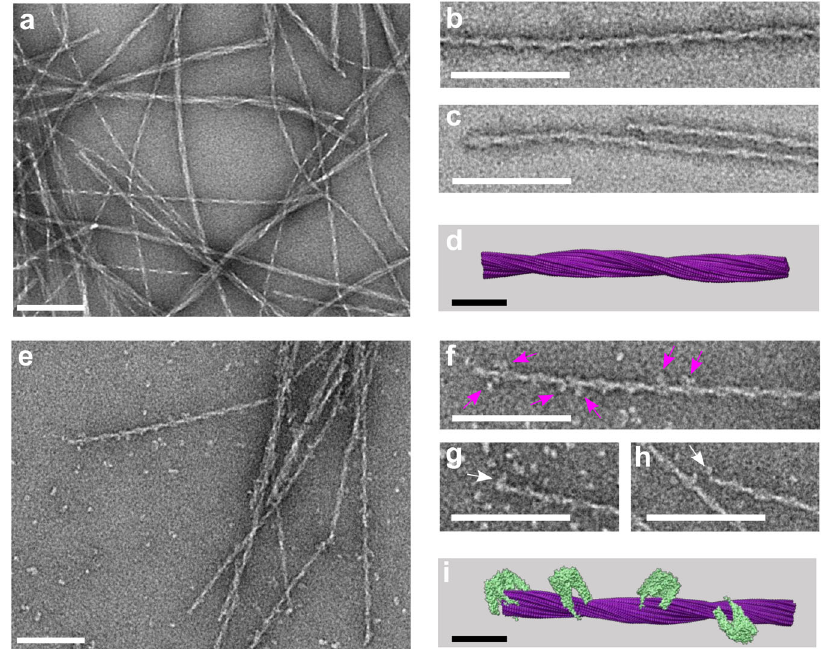
Fig. 4 EM images of PhPFD bound to IAPP fi brils. a Electron microscopy images of IAPP fi brils, stained with sodium silicotungstate (SST) at 30,000x magni fi cation. b , c Close-ups of main fi bril species. d Molecular model of polymorph 1 of the IAPP fi bril (PDB: 6Y1A) 13 . e Preformed IAPP fi brils (67 µ M, monomer equivalent concentration) were incubated with PhPFD in a ratio of 100:1 for 30 min and imaged under the same conditions as IAPP fi brils ( a ). Decoration of the fi bril surface with PhPFD is observed, remaining PhPFD particles are observed in the background. f – h Close-ups of the fi brils show the decoration of the fi bril surface (pink arrows) and end (white arrows). i Molecular model corresponding to the observed fi bril decoration. Horizontal white and black bars correspond to a length of 100 nm and 10 nm, respectively. Simulated TEM images of ( d , i ) are shown in Supplementary Fig. 10.